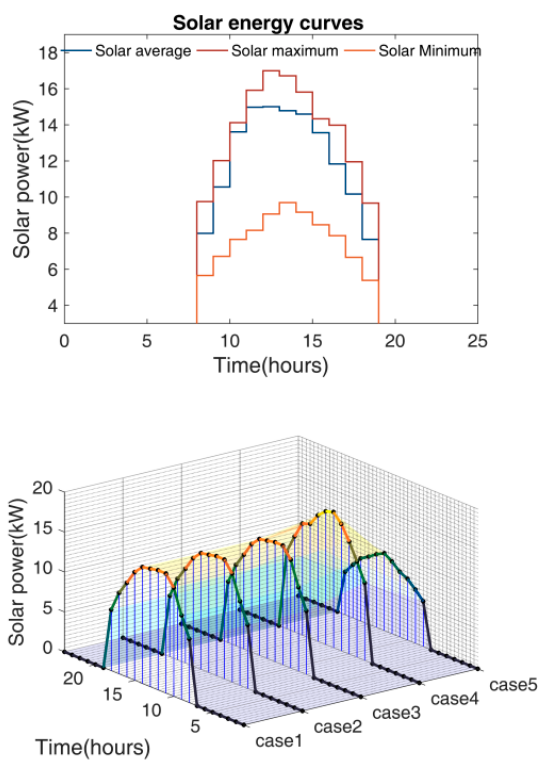
Figure 11. Energy availability from solar .